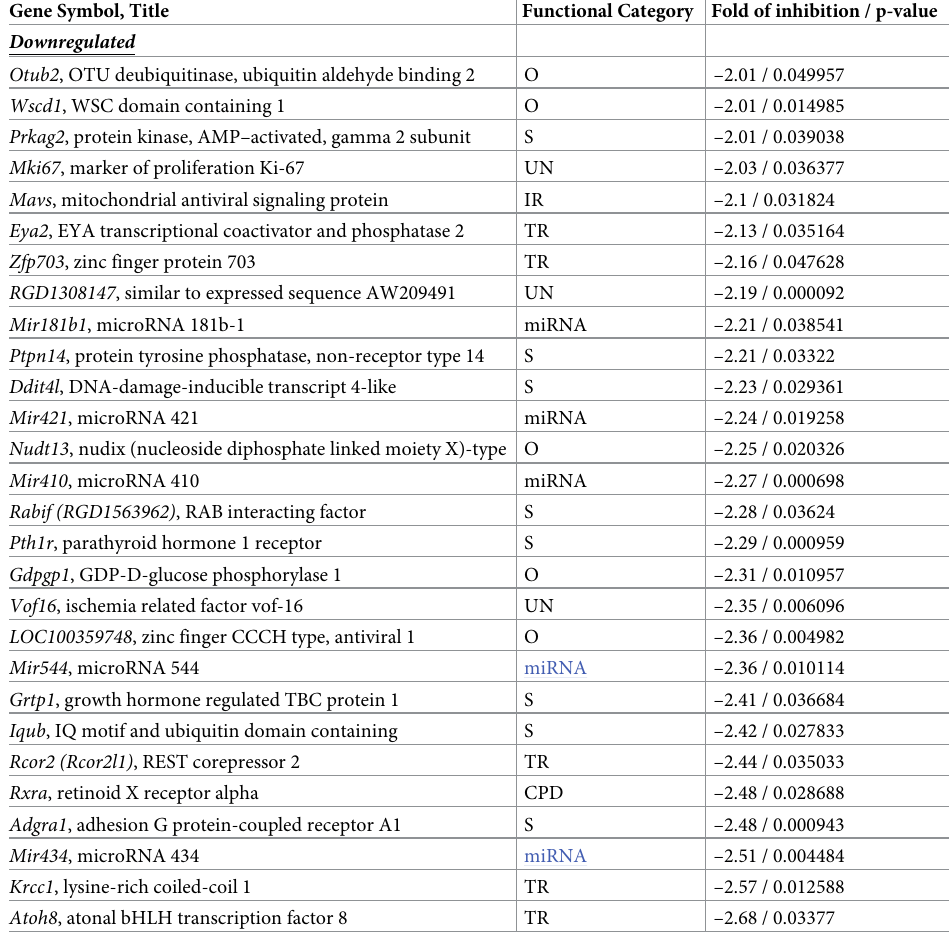
Table 7. Genes whose expression was decreased by 1 mM ouabain by more than 2-fold. Gene Symbol, Title Functional Category Fold of inhibition / p-value